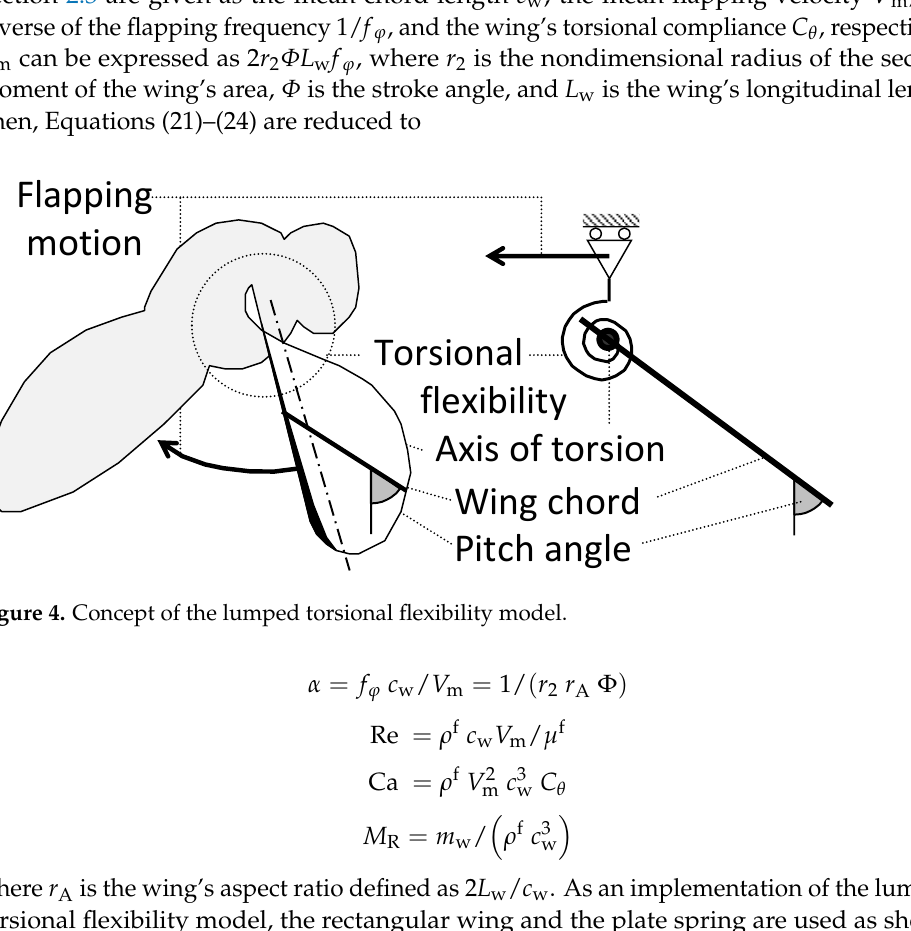
Figure 3. Schematic view of the present dynamic similarity framework.